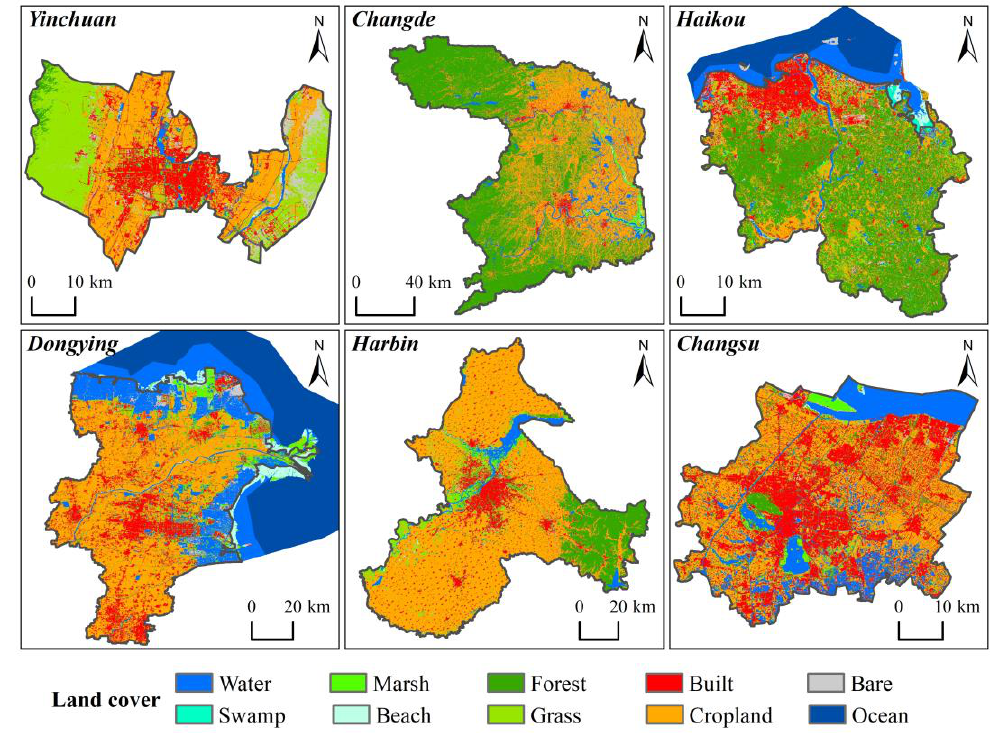
Figure 7. Spatial distribution of land cover for 6 cities in 2020.